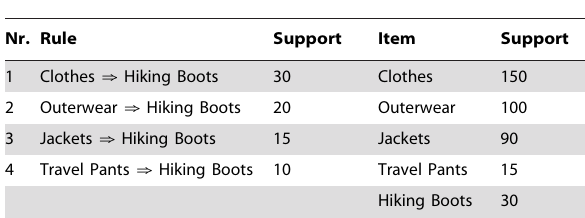
Table 2. Hierarchical Measures Example.